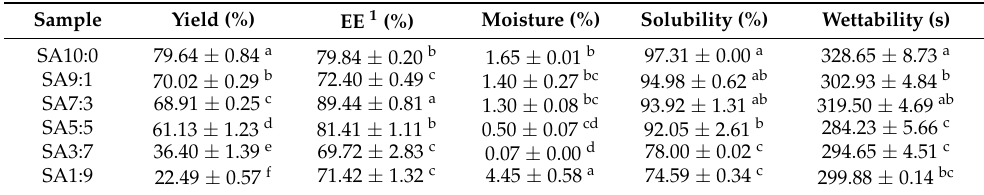
Table 2. The yield, encapsulation efficiency, moisture content, solubility, and wettability of sodium caseinate-acetylated mung bean starch–lutein